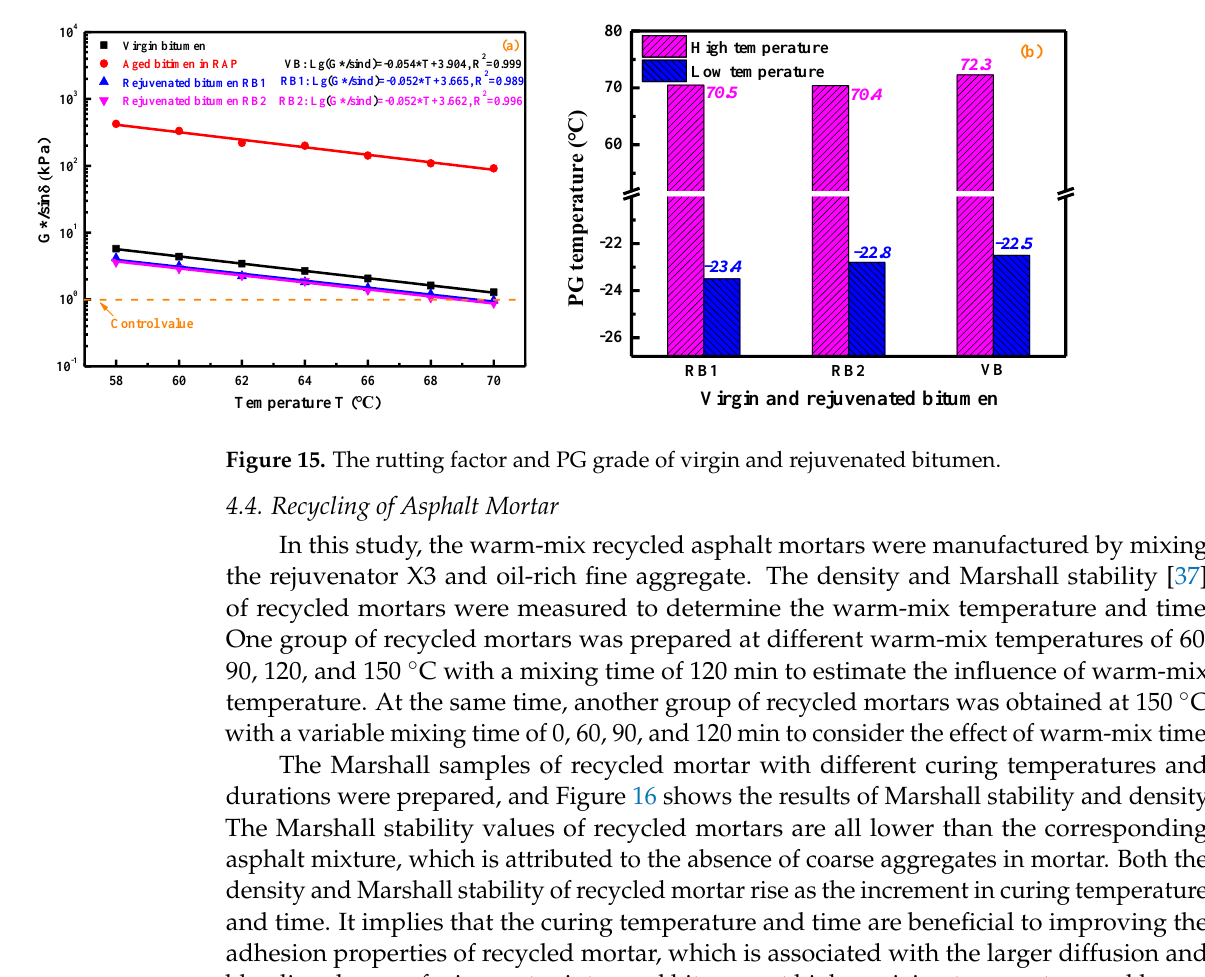
( b ) 0 . 41 Figure 14. The s and m-value of virgin and rejuvenated bitumen. 4.3.5. Rutting Resistance and Performance-Grade of Rejuvenated RAP Bitumen The rutting factor G*/sinδ of the virgin, RAP -aged, and rejuvenated binders were measured, and there is a linearly decreasing trend of G*/sinδ value as the temperature increases. Because of the severe aging oxidation, the RAP-aged bitumen shows the maxi- mum G*/sinδ value [39]. After adding the rejuvenators, the G*/sinδ value of RAP -aged bitumen distinctly declines, slightly lower than virgin bitumen. Although the compound rejuvenator enhances the low-temperature cracking and aging resistance properties of aged bitumen, it also adversely influences the high-temperature rutting resistance. There- fore, the rejuvenator dosage should be optimized to balance the high-and-low tempera- ture properties of rejuvenated bitumen. In addition, the failure temperature of bitumen was determined when the G*/sinδ value was equal to 1.0 kPa. Figure 15b shows the performance-grade of virgin and reju-